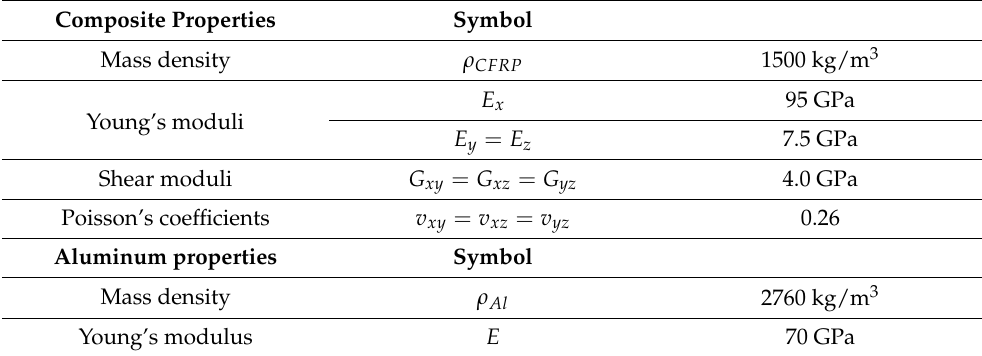
Table 1. Mechanical properties of the unidirectional composite layer and of aluminum used in the FE simulations.